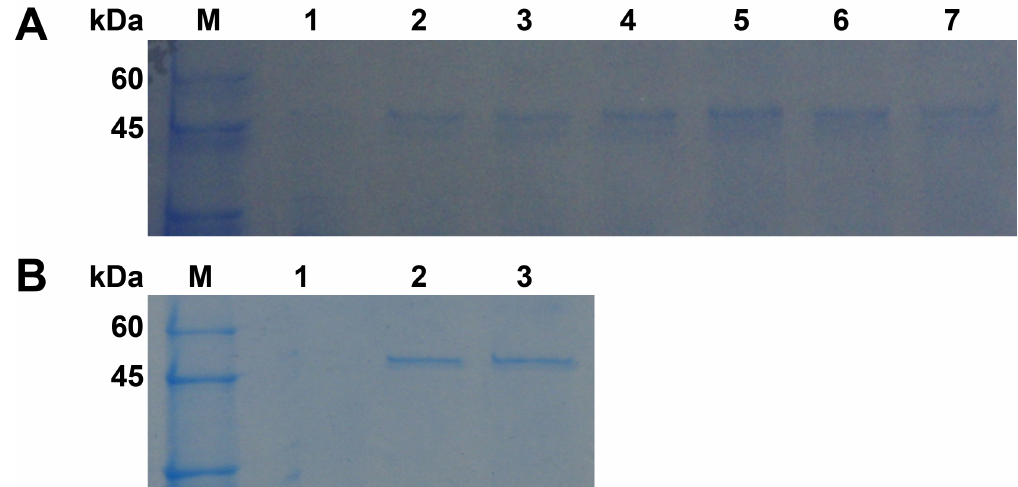
Figure 3. SDS–PAGE analysis of recombinant Pgc4 from Foc1 and Foc4 produced in P. pastoris . ( A ): Cultures were induced with methanol from 1, 2 and 3 days and were collected. Lane M: protein marker; lane 1: cultures transformed with pPICZ α A; lanes 2, 4, 6: culture supernatant from Foc1 at 1, 2, and 3 days; lanes 3, 5, 7: culture supernatant from Foc4 at 1, 2, and 3 days; ( B ): SDS–PAGE analysis of purified Pgc4 from Foc1 and Foc4 produced in P. pastoris . Lane M: protein marker; lane 1: cultures transformed with pPICZ α A; lane 2: purified r-Foc1-Pgc4; lane 3: purified r-Foc4-Pgc4.